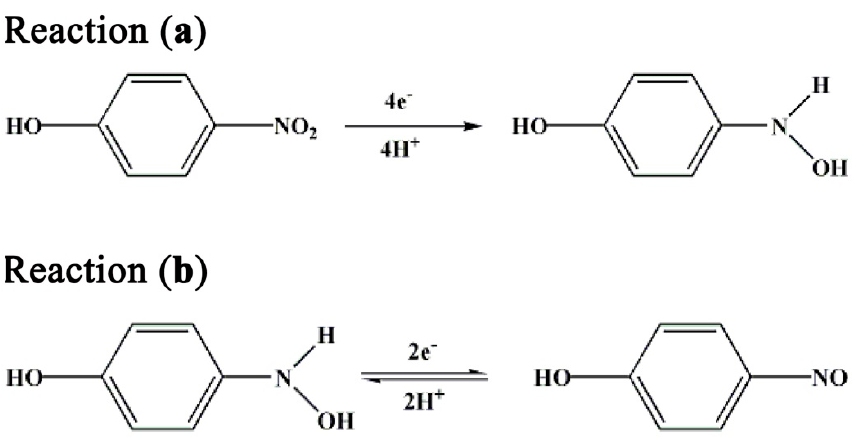
Figure 5. The possible mechanism of p-nitrophenol reduction in this system.